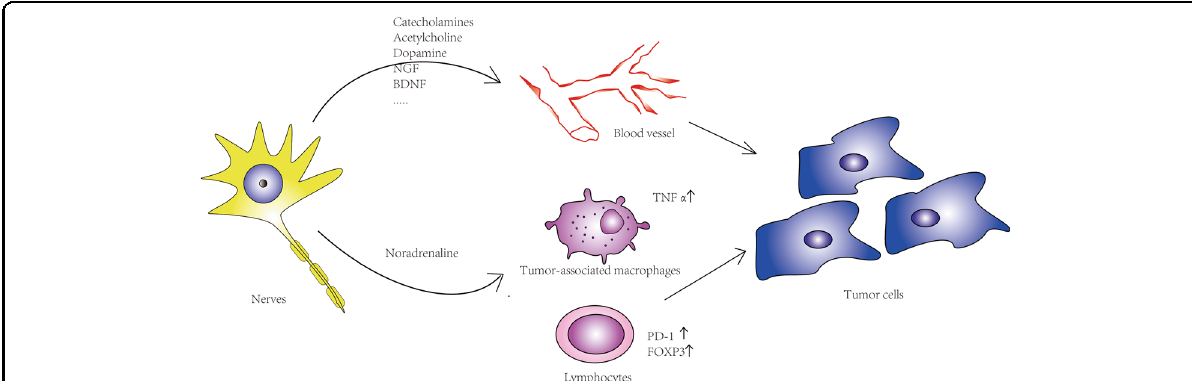
Fig. 3 Nerves affect tumor cell behaviors through indirect pathways. Nerves induce angiogenesis through secreting transmitters and neurotrophic factors. On the other hand, they regulate tumor-associated macrophages via cholinergic and adrenergic signaling. In addition, nerves mediate the expression of immune checkpoint molecules (PD-1, PD-L1 FOXP3) by lymphocytes; all the above processes in fl uence tumor